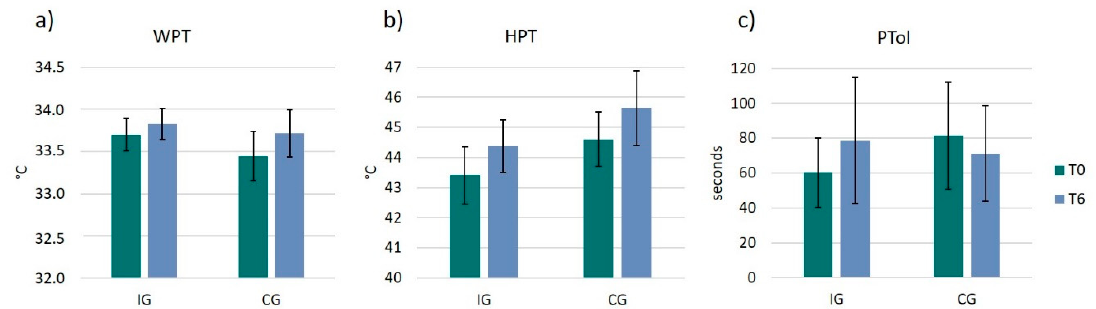
Figure 5. Pain perception and pain tolerance. Bar plots show the 3 parameters of pain perception and pain tolerance for each group (IG and CG) and for each timepoint (T0 and T6): ( a ) warmth perception threshold (WPT); ( b ) heat pain threshold (HPT); ( c ) pain tolerance